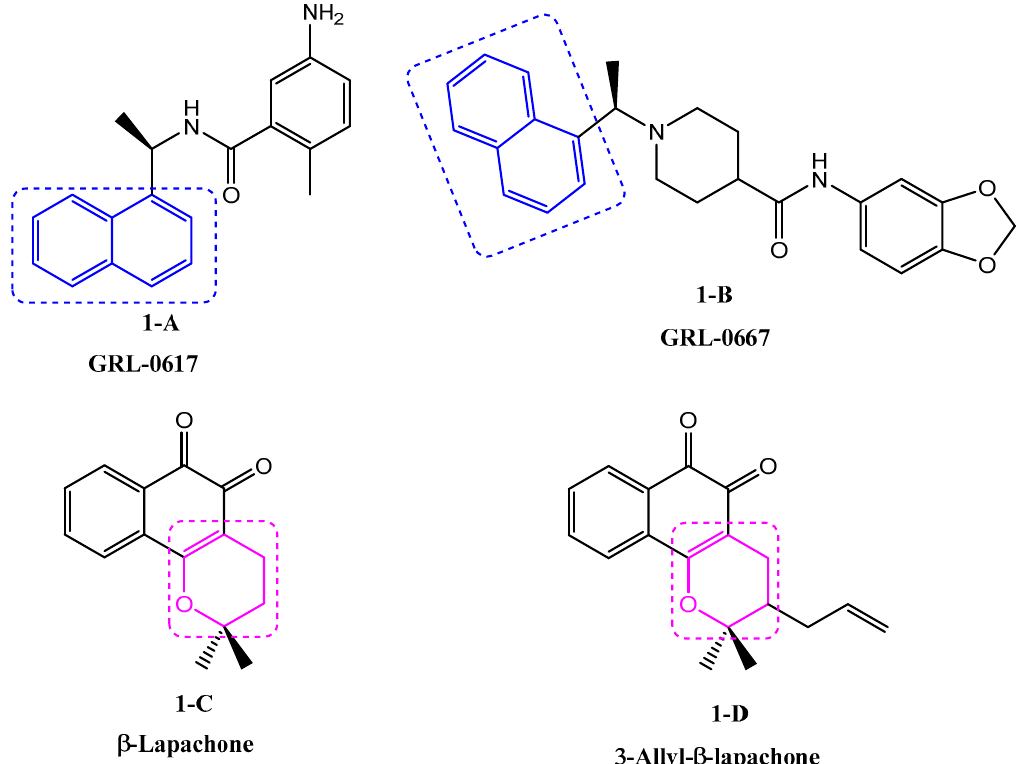
Figure 1. Previously reported antiviral naphthalene and conjugated pyran derivatives.